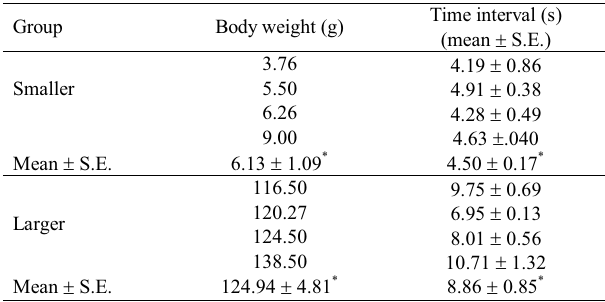
Table 1 . Body weight and the duration of the air-breathing cycle in smaller and larger individuals of Hoplosternum littorale . * Significantly different between groups (U-test,